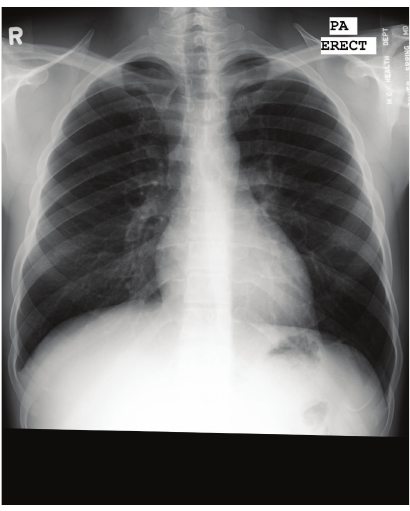
Figure 7: Normal chest X-ray